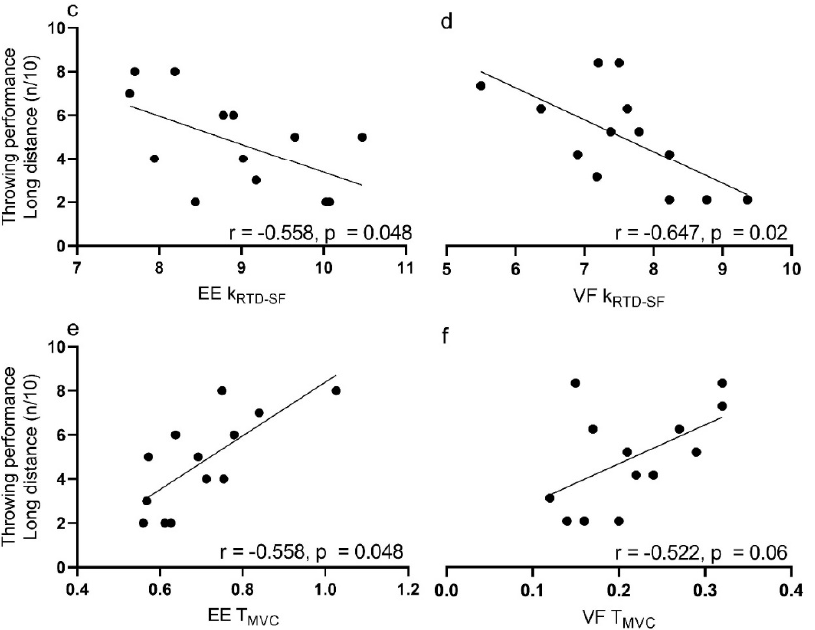
Figure 4. Associations between k RTD-SF ( a – d ), T MVC ( e , f ) of elbow extensors (EE) or volar flexors (VF) and shooting performance from short and long distance.